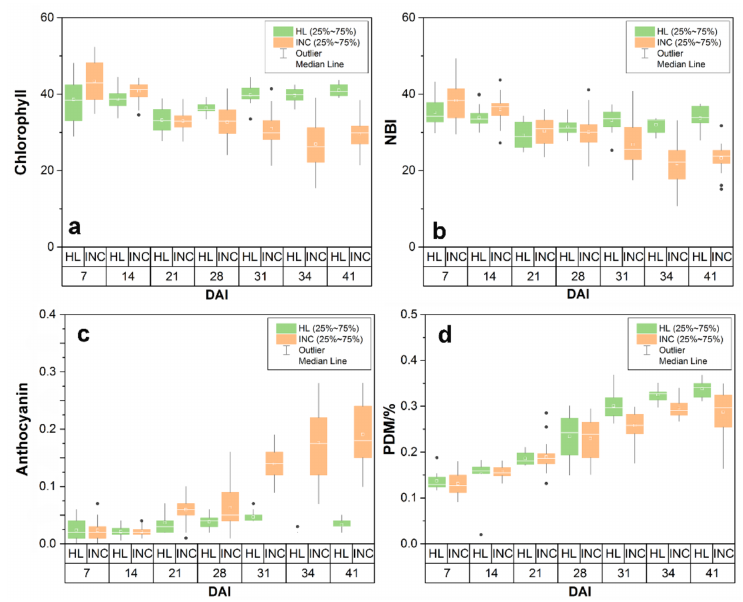
Figure 3. Comparisons of ( a ) chlorophyll index; ( b ) nitrogen balance index (NBI); ( c ) anthocyanin index; ( d ) percentile dry matter (PDM) between healthy leaves and leaves inoculated with yellow rust. The default units for chlorophyll, nitrogen balance index and anthocyanin are from the Duelax instrument.